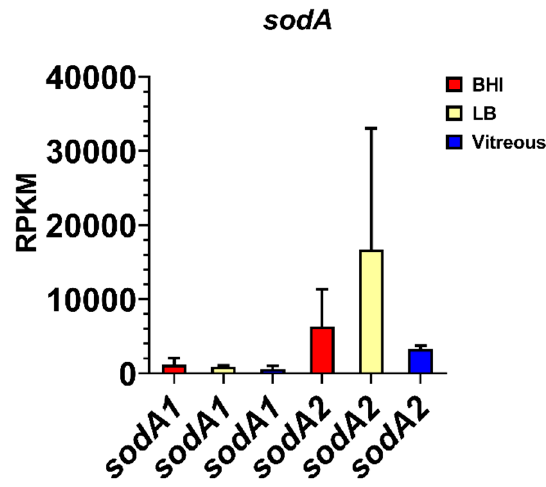
Figure 6. Normalized superoxide dismutase gene expression in each of the three different environments. Reads per kilobase per million (RPKM) for the genes sodA1 and sodA2 . Brain Heart Infusion broth (BHI) is shown in red, Luria-Bertani broth in yellow, and vitreous in blue. RPKM values are the means ± the standard deviations of three independent RNA-Seq runs.